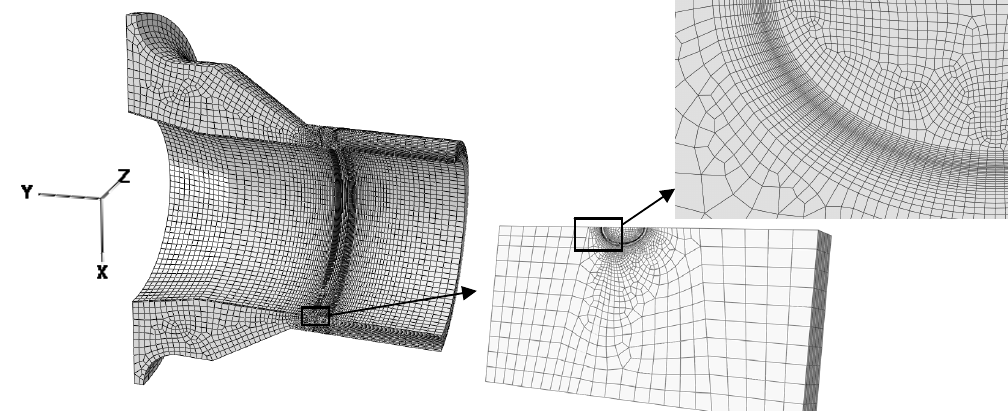
Figure 5: Mesh of the finite element model.